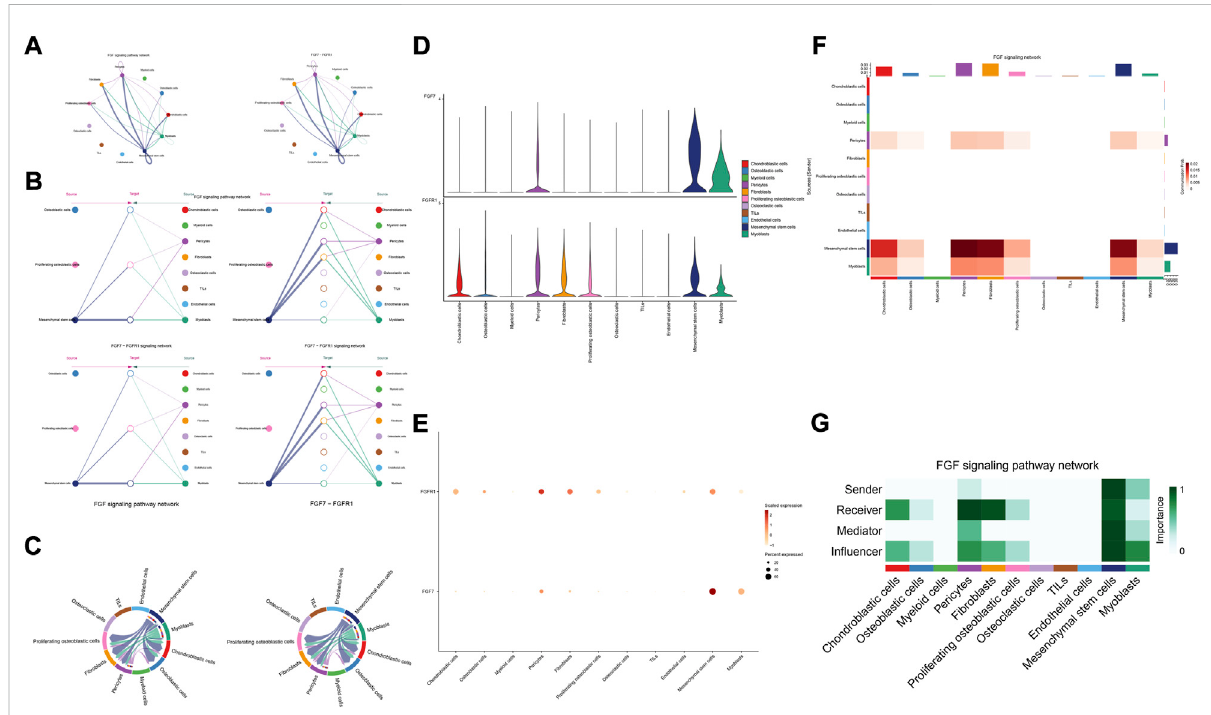
FIGURE 8 FGF signaling pathway. (A – C) : ligand-receptor interactions of cells. (D,E) : the ligand-receptors expressed by each major cell type. (F,G) : the network of FGF signaling